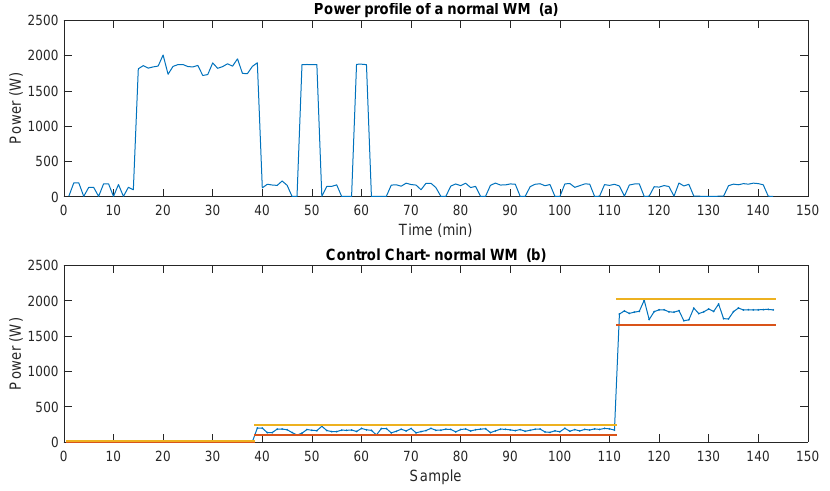
Figure 11. Power profile and CC of an anomaly-free